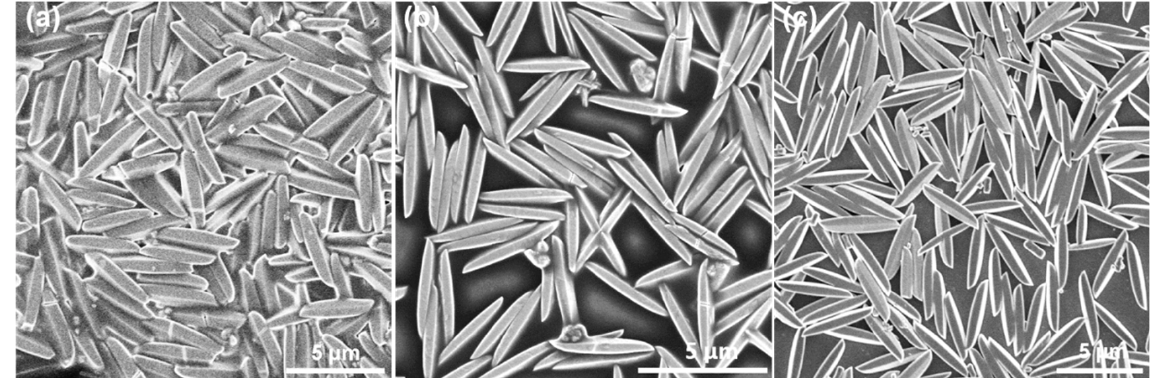
Figure 1. SEM images of ( a ) Cu-MOF, ( b ) CuCo-MOF-1, and ( c ) CuCo-MOF-2 precursors.